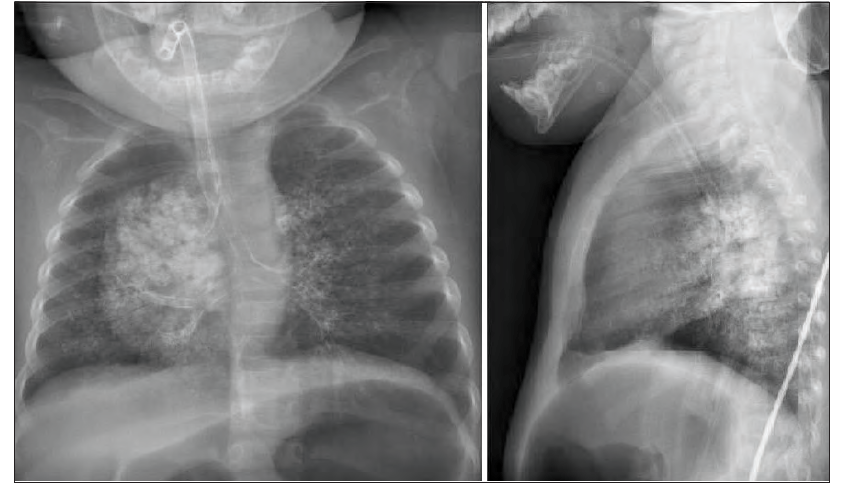
Fig. 4. Frontal and lateral radiographs of the bronchogram study demonstrating the right tracheal bronchus that supplies the posterior segment of the right upper